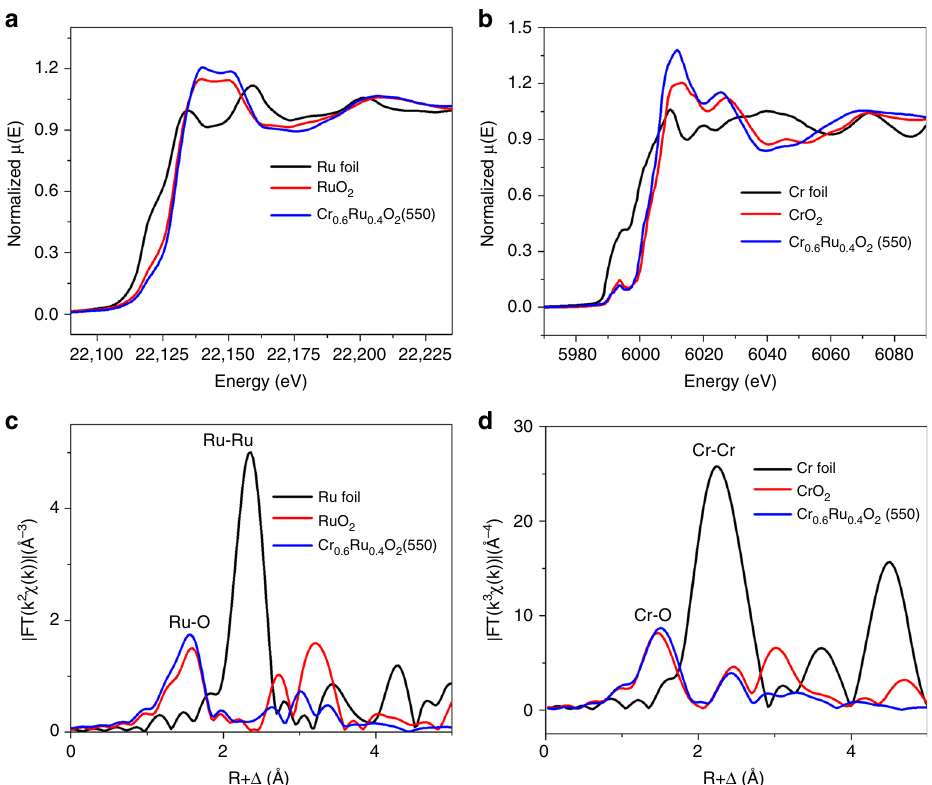
Fig. 7 XAS analysis of Cr 0.6 Ru 0.4 O 2 (550) electrocatalyst. a Normalized Ru K-edge XANES spectra of Cr 0.6 Ru 0.4 O 2 (550), Ru foil and commercial RuO 2 . b Normalized Cr K-edge XANES spectra of Cr 0.6 Ru 0.4 O 2 (550), Cr foil, and commercial CrO 2 . c Fourier transformed EXAFS spectra of Ru edge for Cr 0.6 Ru 0.4 O 2 (550), Ru foil and commercial RuO 2 . d Fourier transformed EXAFS spectra of Cr edge for Cr 0.6 Ru 0.4 O 2 (550), Cr foil, and commercial CrO